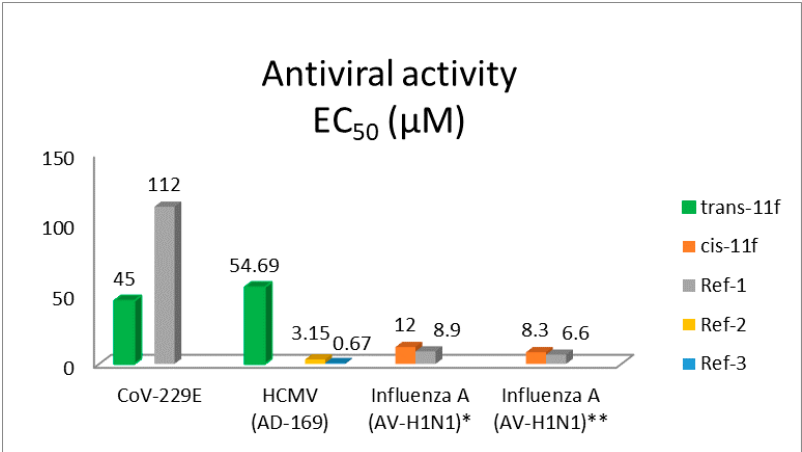
Figure 3. Antiviral activity found for the stereoisomers of 3-methyl-4-fluorophenyl derivatives of azetidinone trans - 11f and cis- 11f in comparison with reference antiviral agents: ribavirin (Ref-1), ganciclovir (Ref-2), cidofovir (Ref-3). The ability to inhibit viral replication expressed with EC 50 value (µM). * EC 50 by visual CPE score; ** EC 50 by TMS score.